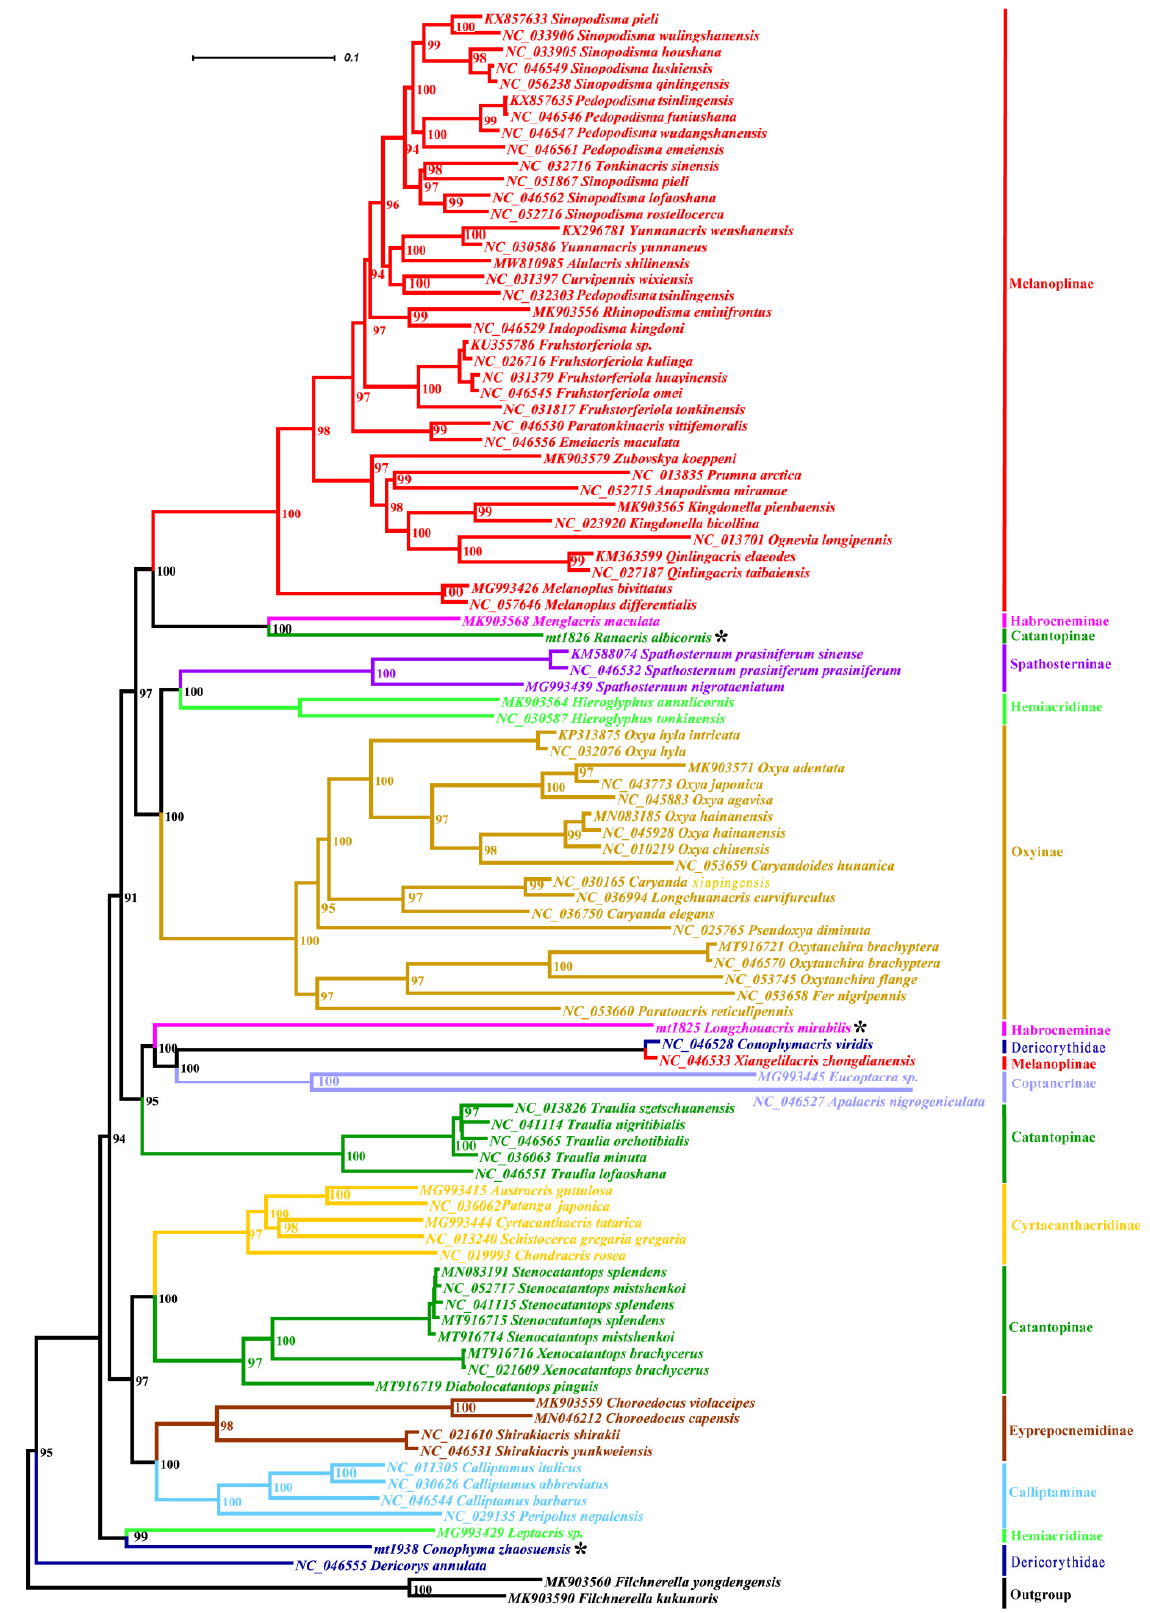
Figure 2. Phylogenetic tree reconstructed from the sequences of the 13 mitochondrial PCGs using maximum likelihood. The asterisk indicates the three newly sequenced